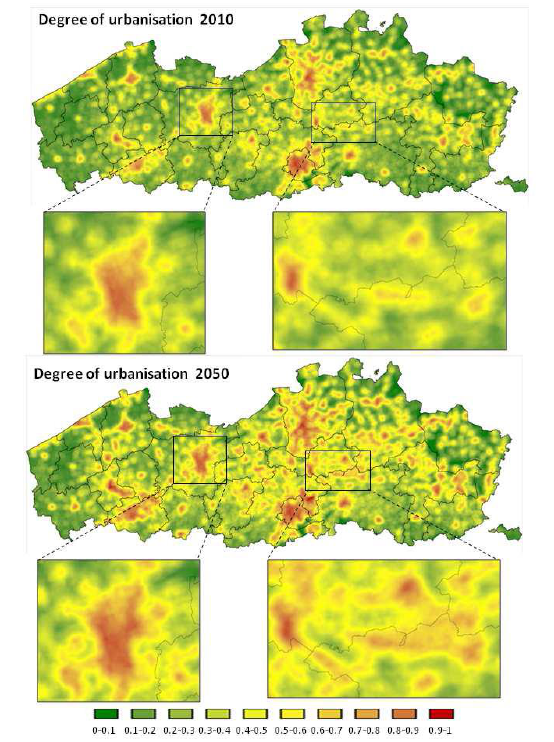
Figure 5. Degree of urbanisation 2010 vs 2050